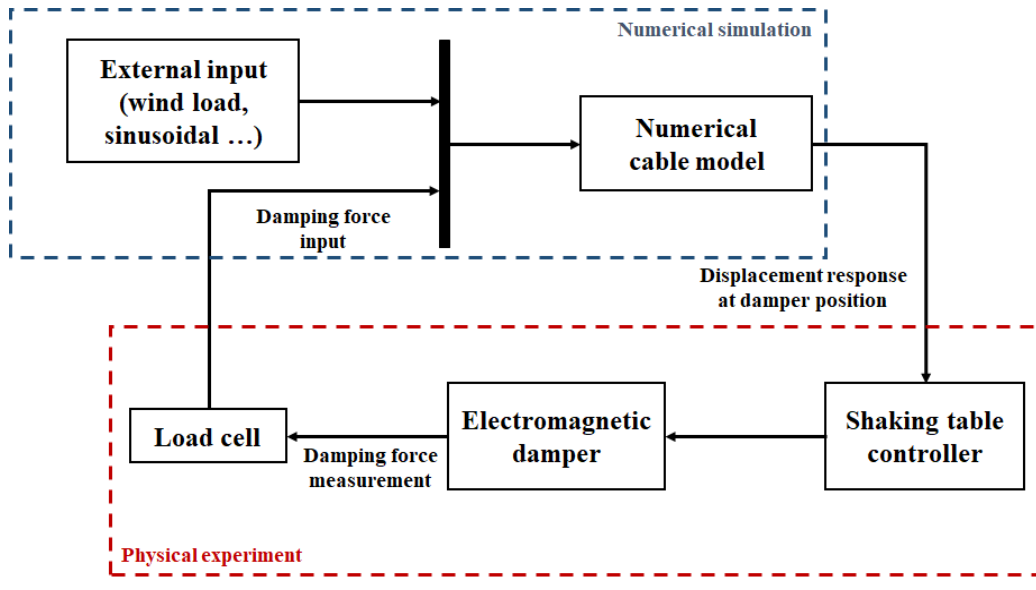
Figure 7. Block diagram of the hybrid simulation.